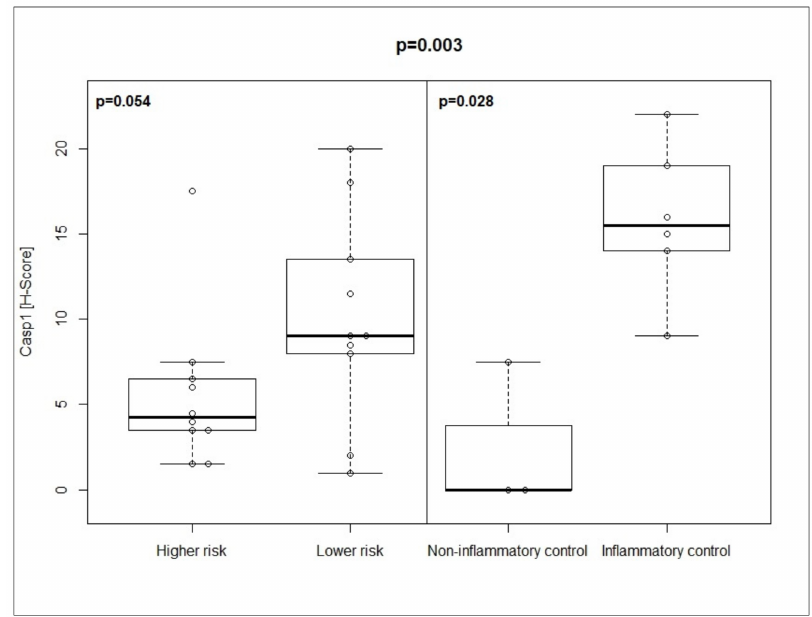
Figure 1. Expression of Casp1 in MDS patients and controls. H-scores are shown as median with ranges. p -values were calculated with Mann–Whitney U test for univariate and Kruskal–Wallis test for multivariate analysis. Significance was determined at p < 0.05. Cohen’s effect size r was large at